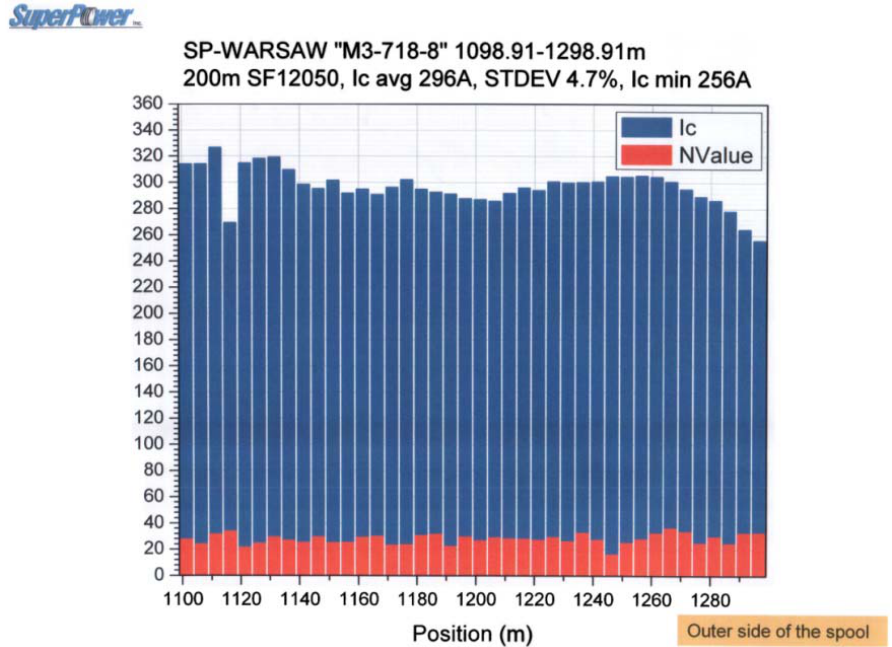
Figure 15. Significant differences in the value of the critical current measured every 5 m by the manufacturer of the HTS 2G tape. Liquid nitrogen temperature, natural field [7,14] .